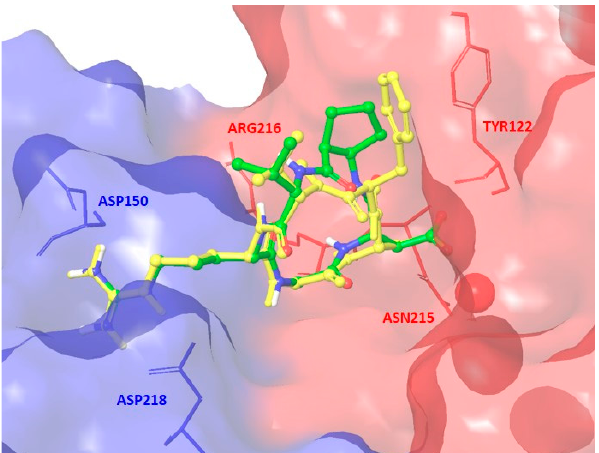
Figure 5. Docking best pose of compound 8 (Type I, green C atoms, Gscore = − 9.26 kcal/mol) in the crystal structure of the extracellular domain of α v β 3 integrin ( α unit blue, β unit red) overlaid on the bound conformation of Cilengitide (yellow). Only selected integrin residues involved in interactions with the ligand are shown. The metal ion at MIDAS is shown as a red CPK sphere (space-filling model by Corey, Pauling, Koltun). Nonpolar hydrogens are hidden for clarity.